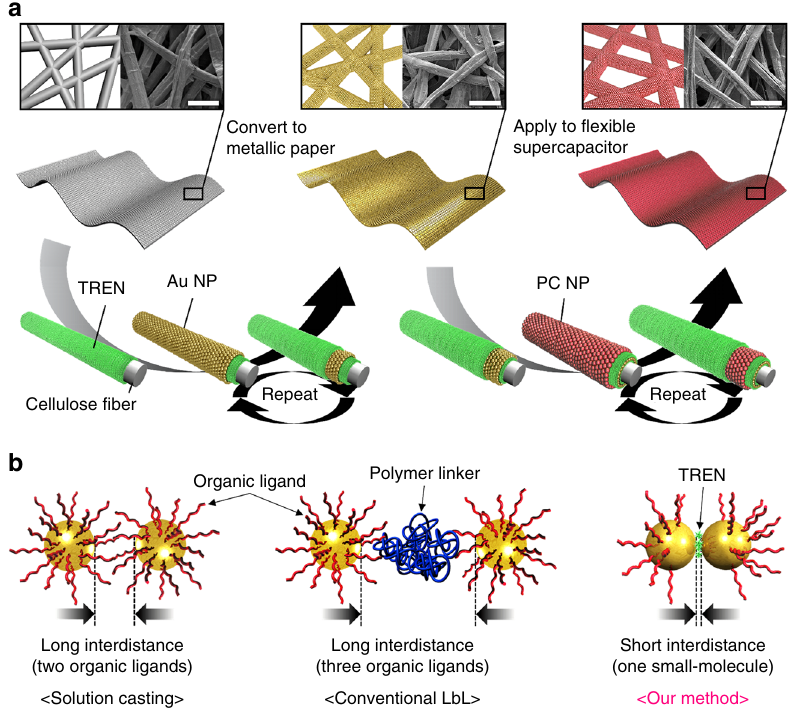
Fig. 1 Metallic paper (MP)-based supercapacitor electrode. a Schematic for the preparation of the MP-based supercapacitor electrodes using ligand- mediated layer-by-layer (LbL) assembly between hydrophobic metal (or metal oxide) nanoparticles (NPs) and TREN molecules. In this case, the internal porous structure of the paper is perfectly preserved even after deposition of the NPs as shown in FE-SEM images. All scale bars in FE-SEM images indicate 50 µ m. b Schematic diagram showing the difference between the conventional solution casting of the NPs ( left ), traditional LbL assembly (based on electrostatic interactions, hydrogen bonding, or covalent bonding) ( middle ), and our approach (i.e., molecule ligand-mediated LbL assembly) ( right